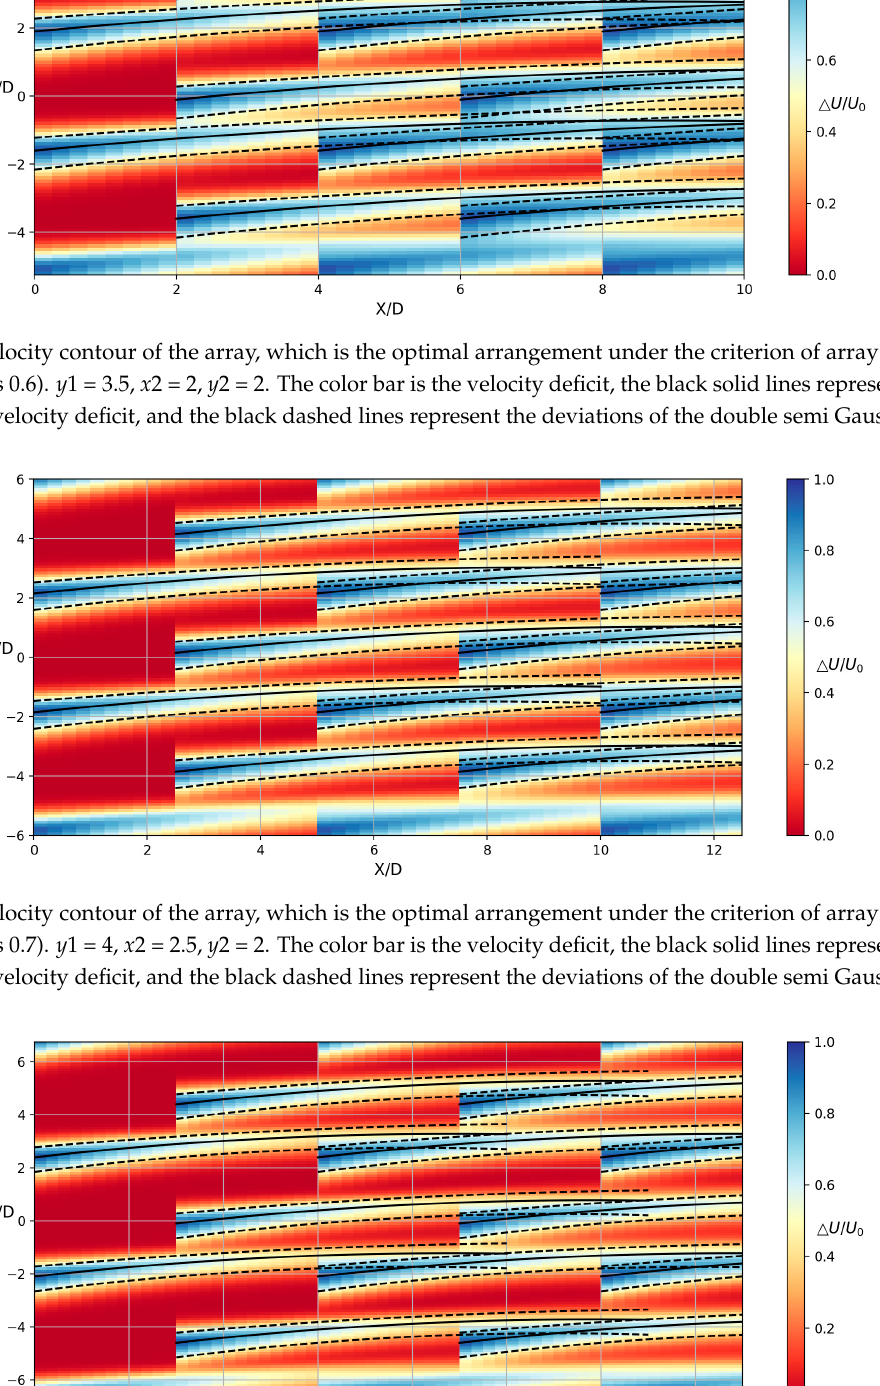
Figure 19. The velocity contour of the array, which is the optimal arrangement under the criterion of array power density (truncation ratio is 0.8). y 1 = 4.5, x 2 = 3, y 2 = 2.5. The color bar is the velocity deficit, the black solid lines represent the position of the maximum velocity deficit, and the black dashed lines represent the deviations of the double semi Gaussian functions.